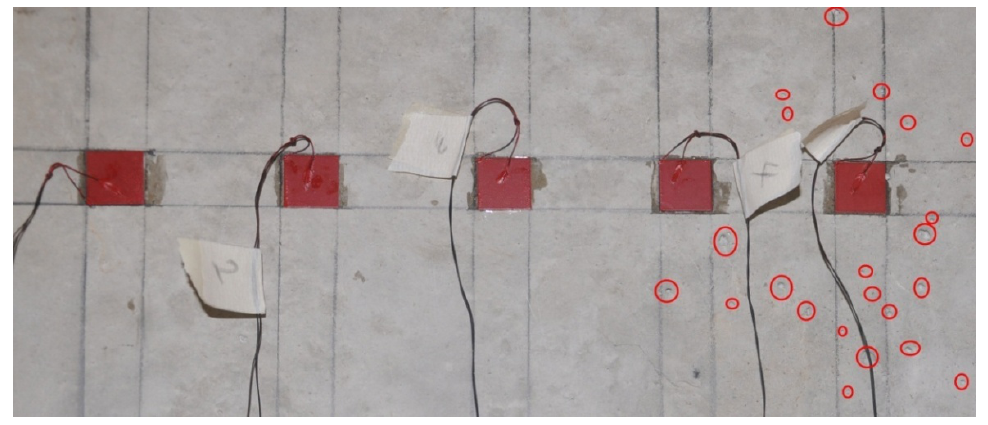
Figure 17. Surface condition near